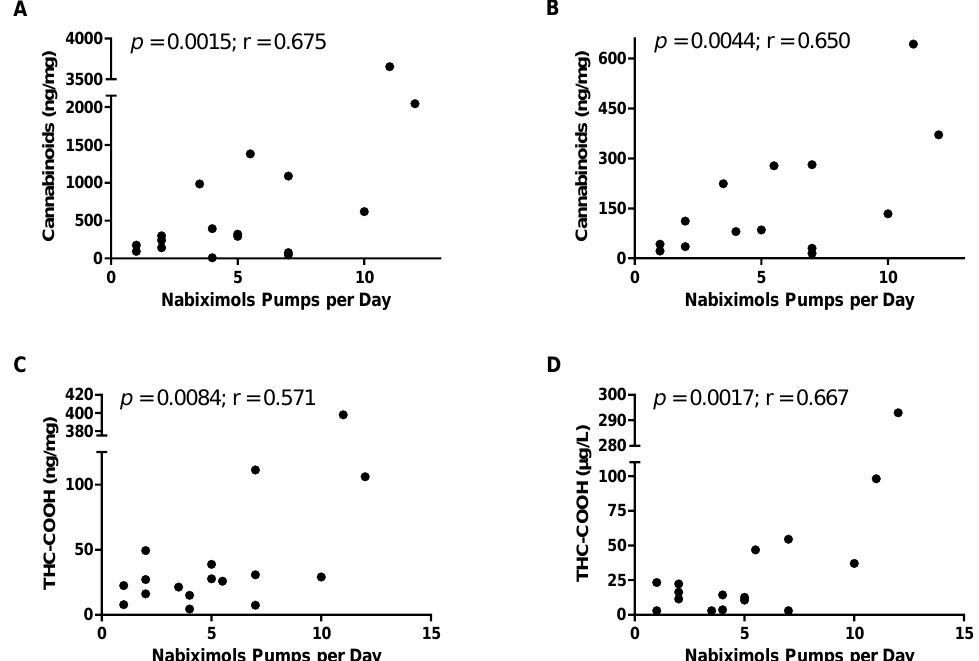
Figure 2. Correlations of cannabinoid concentrations versus nabiximols doses in MS patients. Cannabinoid concentrations were assessed by the immunological method in urine samples after normalizing to creatinine in non-hydrolyzed ( A ) or hydrolyzed ( B ) samples. Specific THC-COOH was measured by GC/MS in non-hydrolyzed urine samples after normalizing to creatinine ( C ) or in plasma ( D ). Statistical analysis was performed using Pearson’s product-moment correlation.